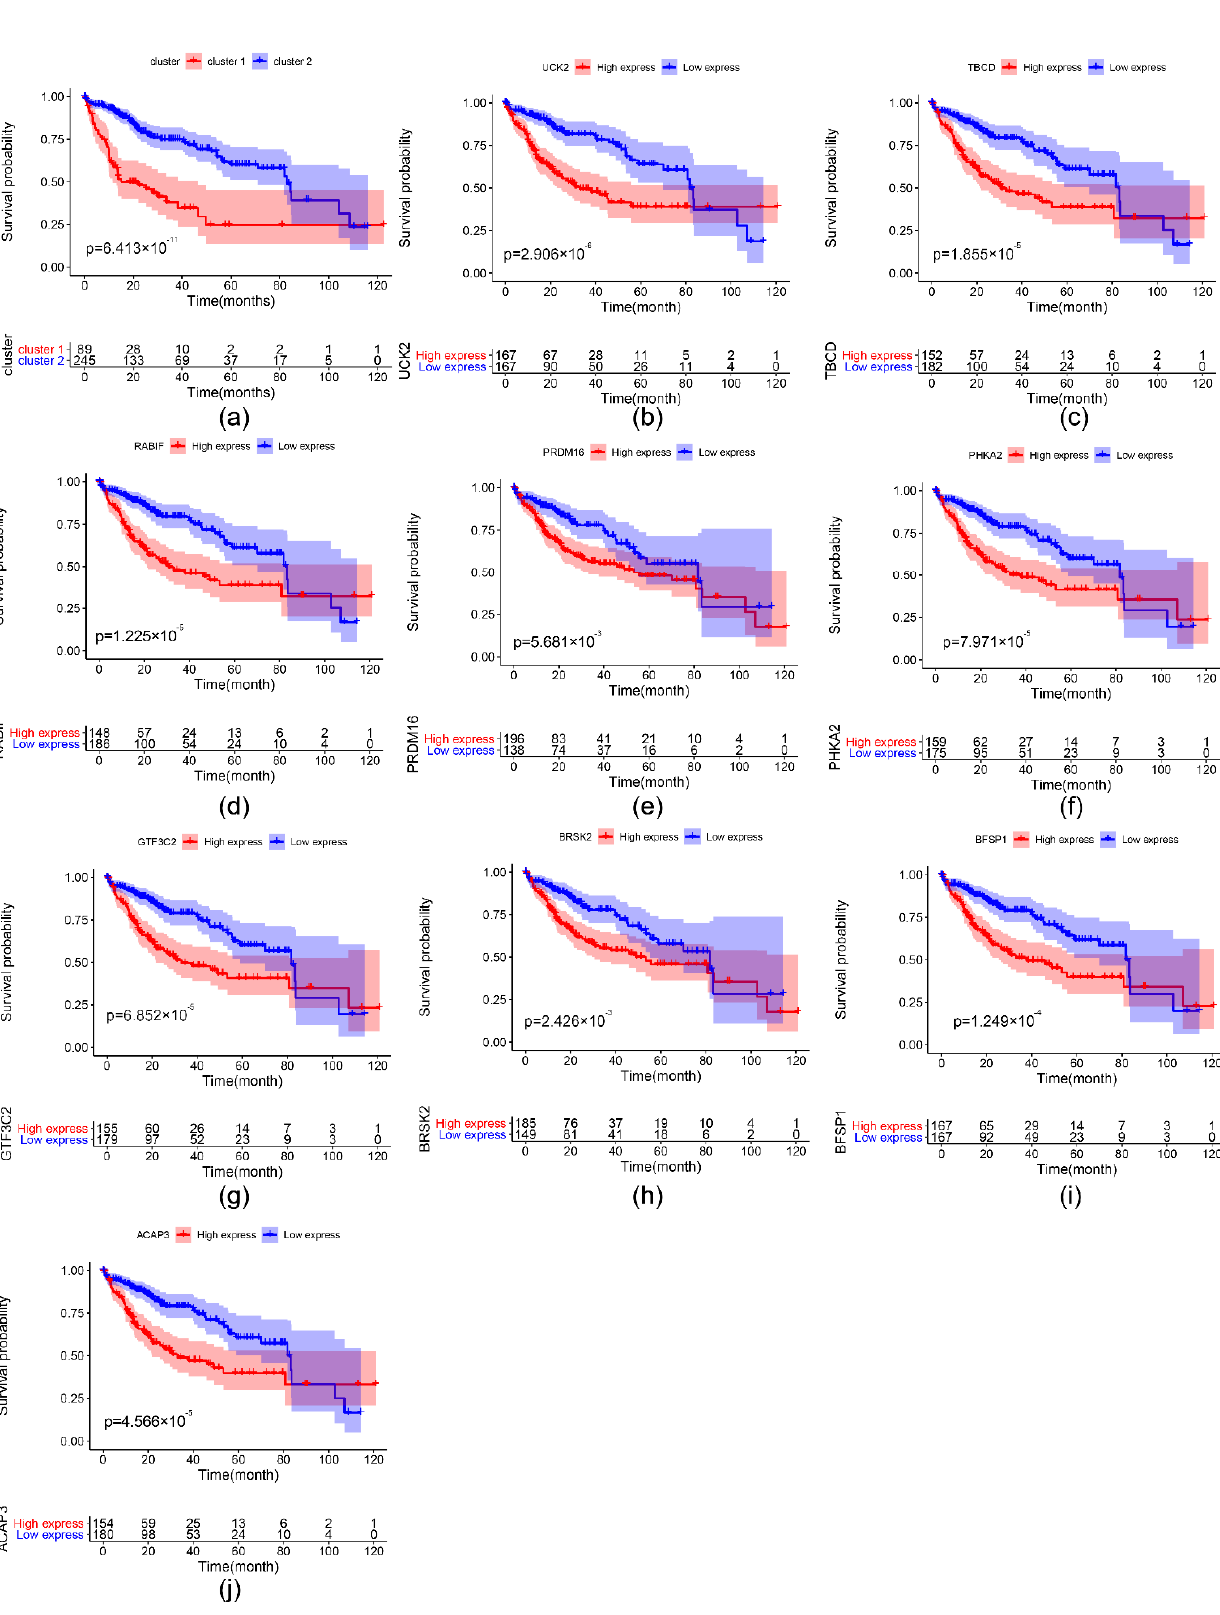
Figure 8. Kaplan–Meier analysis of clusters according to the ConsensusClusterPlus and the important survival-related m6A RNA methylation-related genes. ( a ) Kaplan–Meier curves of TCGA samples which were divided into 2 clusters according to the ConsensusClusterPlus. ( b – j ) Kaplan–Meier curves of the important survival-related m6A RNA methylation-related genes. The unit of survival time is months.